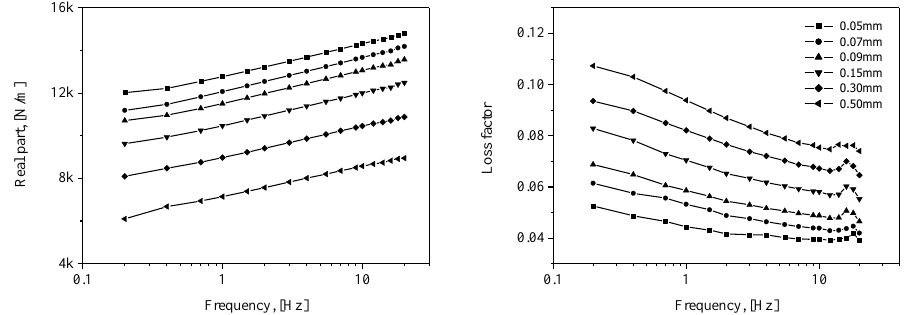
Figure 9. Calculated complex stiffness of the inflated rubber diaphragm k* d ; real part: Re[ k* d ]; loss factor: Im[ k* d ]/Re[ k* d ].